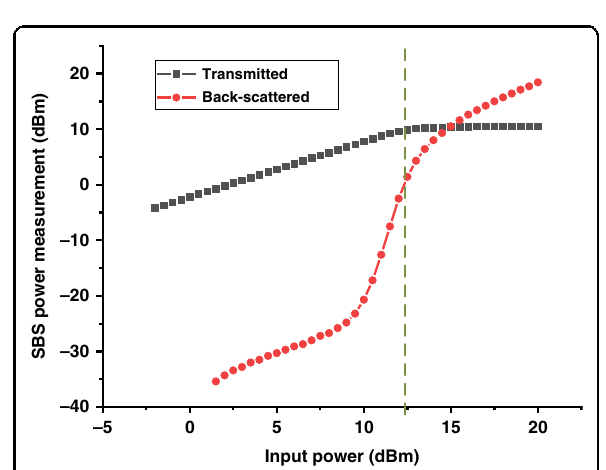
Fig. 11 SBS threshold measurement result for 7.4 km SSMF Transmitted (squares) and back-scattered (circles) optical power versus launched optical power into the SSMF. The green dashed line indicates the measured SBS threshold of the 7.4 km